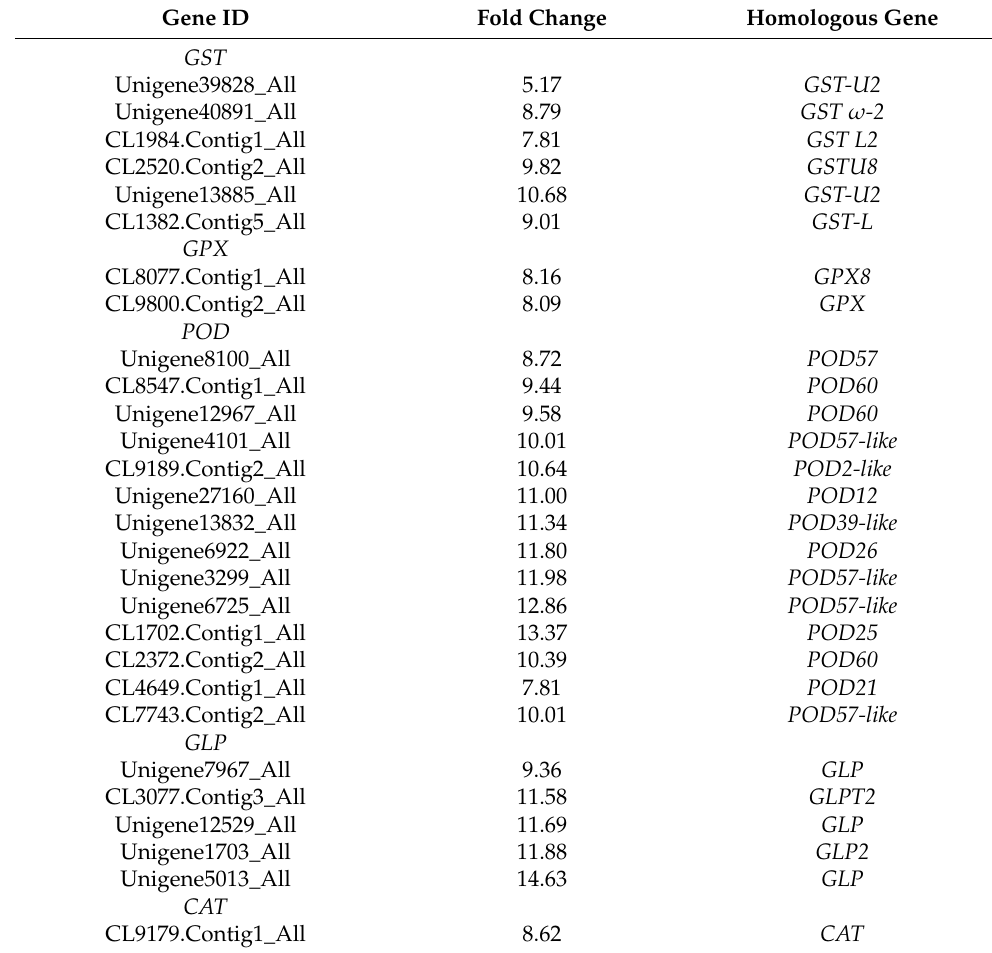
Table 1. The upregulated DEGs related to the ROS scavenging system in the leaves of A. canescens under 100 mM NaCl but not under the control condition for 6 h. Gene ID Fold Change Homologous